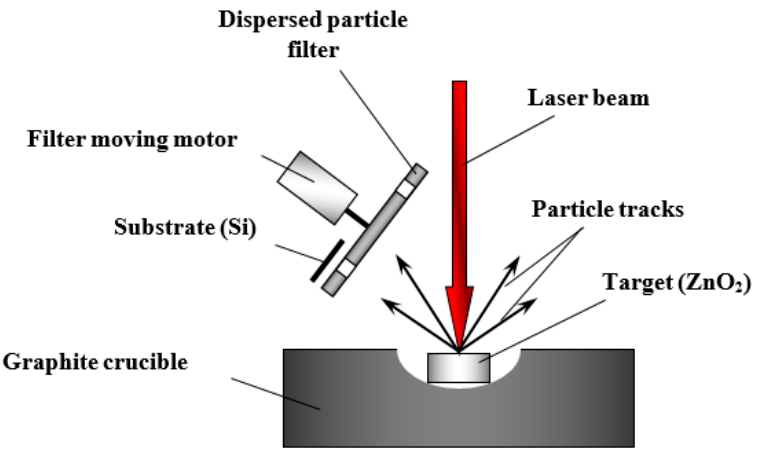
Figure 10. Experimental setup for coating deposition by laser ablation [89].